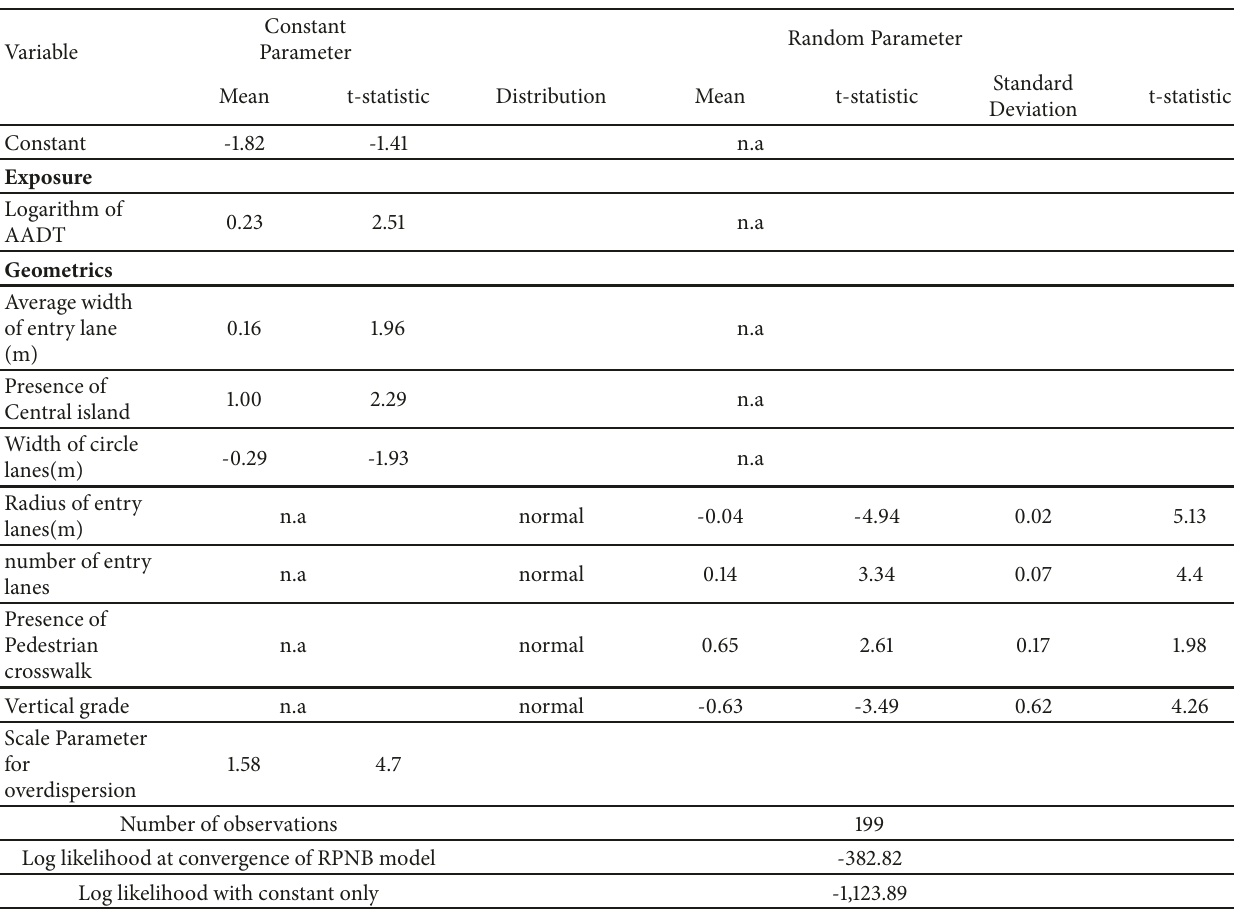
Table 5: Estimation results of roundabout accident frequencies in Korea.